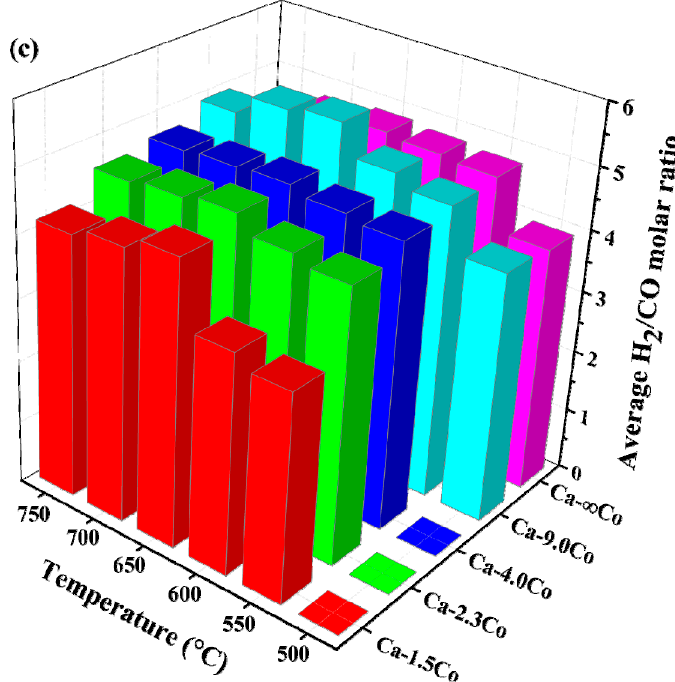
Figure 6. Effect of reaction temperature and calcium to cobalt mass ratio on: ( a ) methane conversion; ( b ) hydrogen yield; and ( c ) average H 2 /CO molar ratio, at S/C = 2.